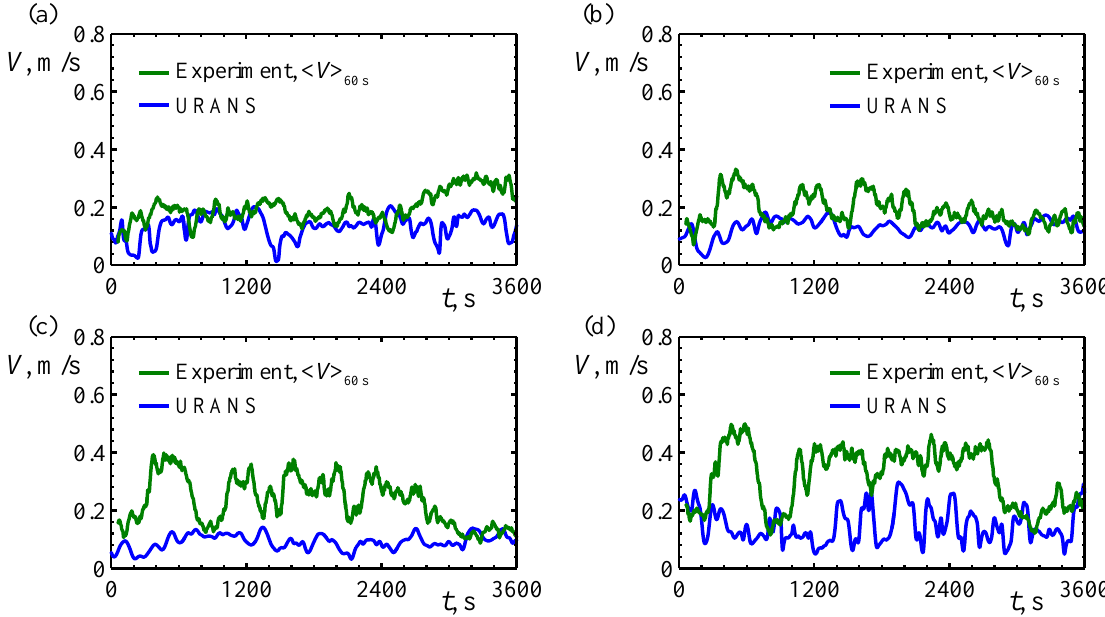
Figure 6. Time evolution of velocity magnitude at four monitoring points: ( a ) z = 0.1 m, ( b ) z = 0.6 m, ( c ) z = 1.1 m and ( d ) z = 1.7 m (data for θ = 25°, experimental case #1 and computational case #2). The computed and measured mean velocity data are compared in Figure 7. The computed data, extracted from the time-averaged computational solution, are presented as solid lines covering the whole room height (both the jet zone and the occupied zone). The symbols illustrate all the experimental data available for the occupied zone.